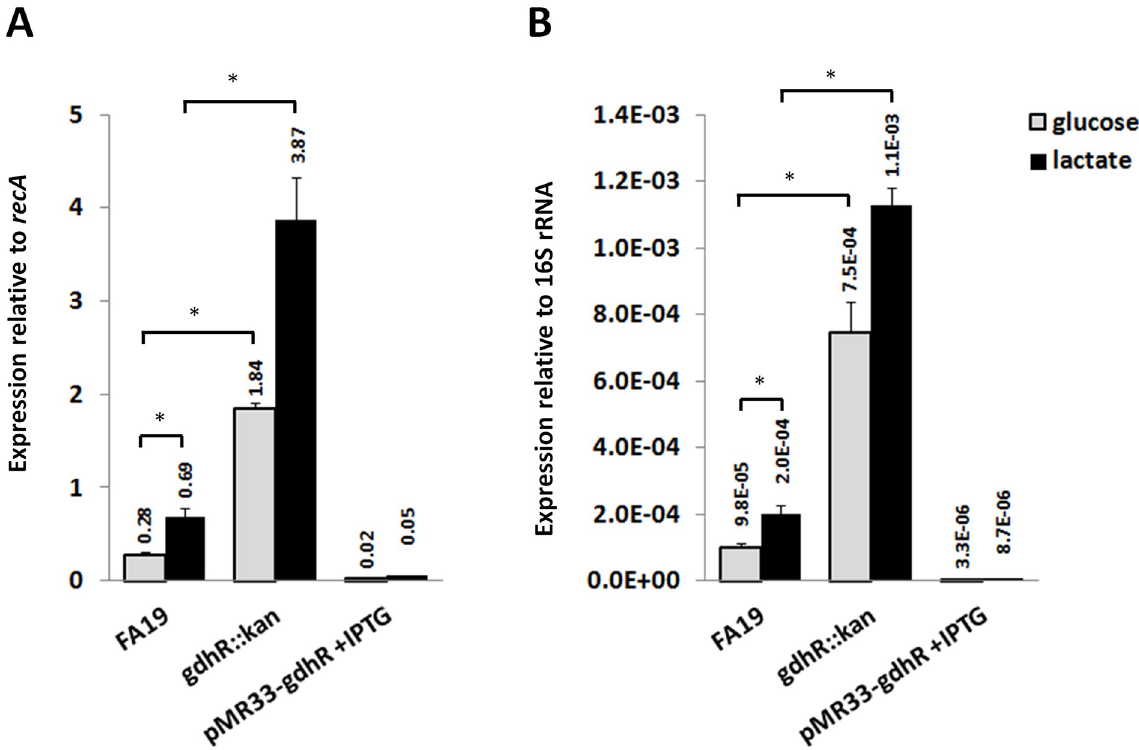
Fig 2. Regulation of the lctP allele by GdhR. Relative levels of lctP mRNA were determined by qRT-PCR using recA (A) or 16S rRNA (B) as internal reference in total RNA samples from WT strain FA19 and its isogenic mutants gdhR :: kan and gdhR :: kan complemented strain JC02 (pMR33- gdhR ). Cells were grown to late-logarithmic phase in GC broth supplemented with either glucose (grey bars) or lactate (black) at 22 mM each. Data are presented as the mean (bar) plus the standard error of the mean (error bar) of 3 biological samples. � represents significant statistical differences at p < 0.05 as determined by a one-tailed non-parametric Mann Whitney U-test.